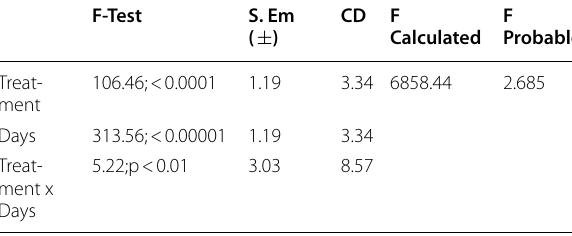
Table 1 In vivo feeding assay of endophytically colonized Beauveria bassiana UHSB-END1 tomato leaves against Spodoptera litura larvae